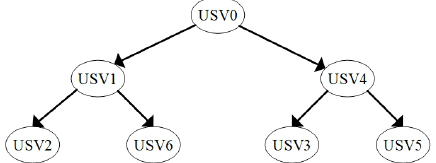
Figure 3. Directed communication topology.